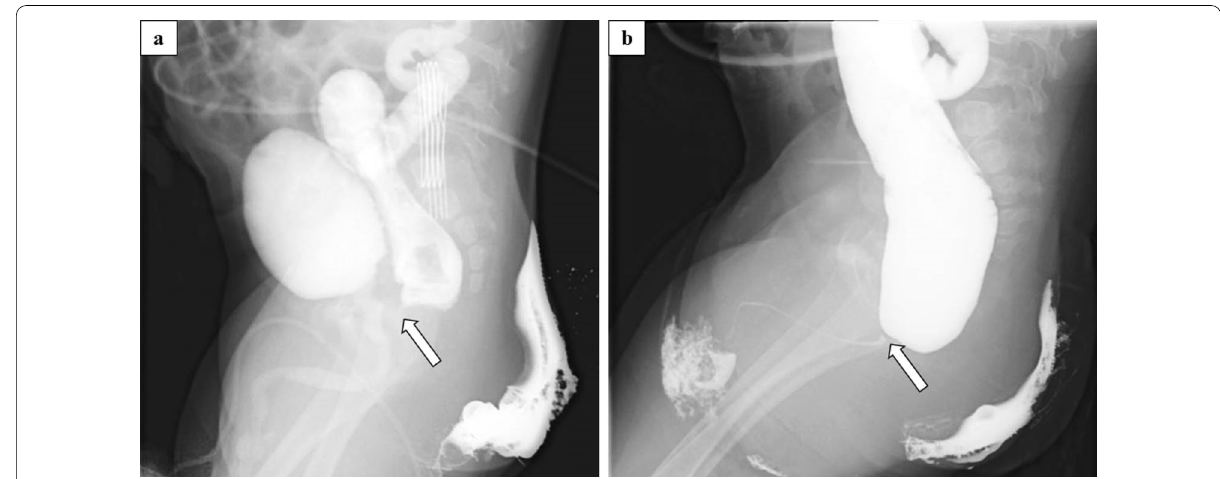
Fig. 1 a Voiding cystourethrogram and distal colostogram. Recto-urethral fistula was suspected (arrow), but was not clearly visualized. b High-pressure distal colostgram. Recto-bulbar urethral fistula (RBUF) was detected